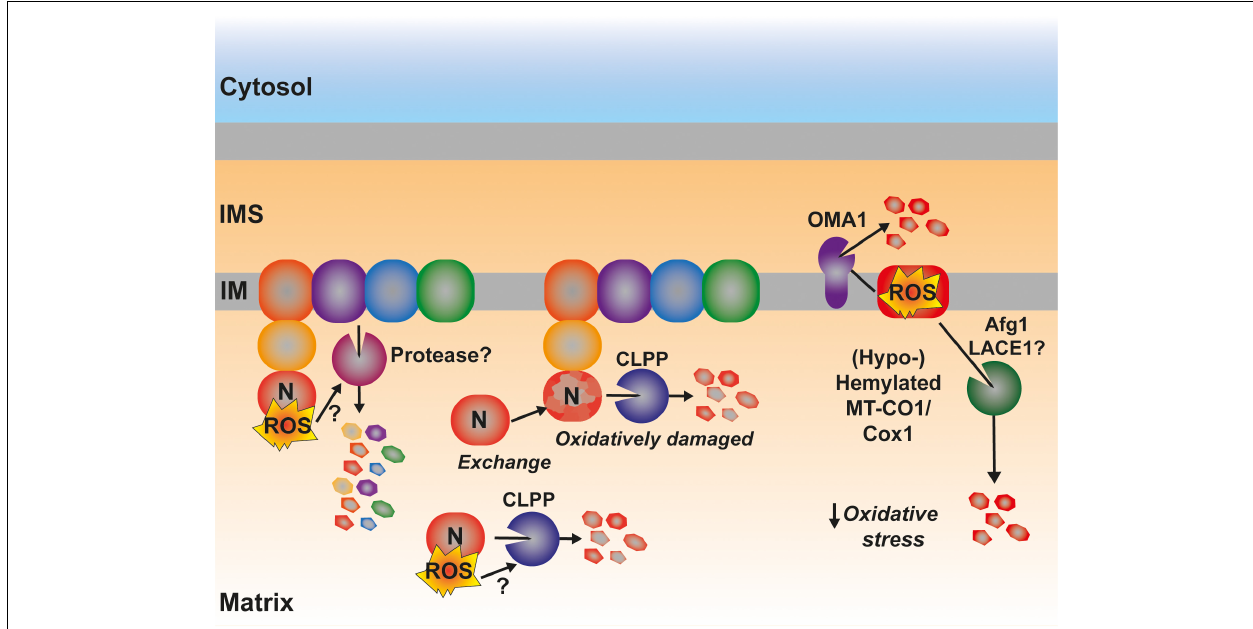
FIGURE 7 | Possible involvement of ROS in the regulation of the degradation by active proteolysis of some of the catalytical components of the ETC. ROS produced by RET at the level of CI have been proposed to trigger the degradation of the full complex. The mechanistic details are still unknown. The matrix protease CLPP is responsible for the degradation of the catalytic N-module of CI, preventing its accumulation as an assembly intermediate in the mitochondrial matrix as well as promoting the interchange of an oxidatively damaged N-module for a newly synthesized one. Some Cox1 (MT-CO1) intermediates are actively degraded by the inner membrane-bound protease OMA1, which is redox activated. Other pro-oxidant Cox1 intermediates are degraded through a mechanism mediated by the AAA-ATPase Afg1 in yeast being LACE1 its human ortholog. See main text for details.